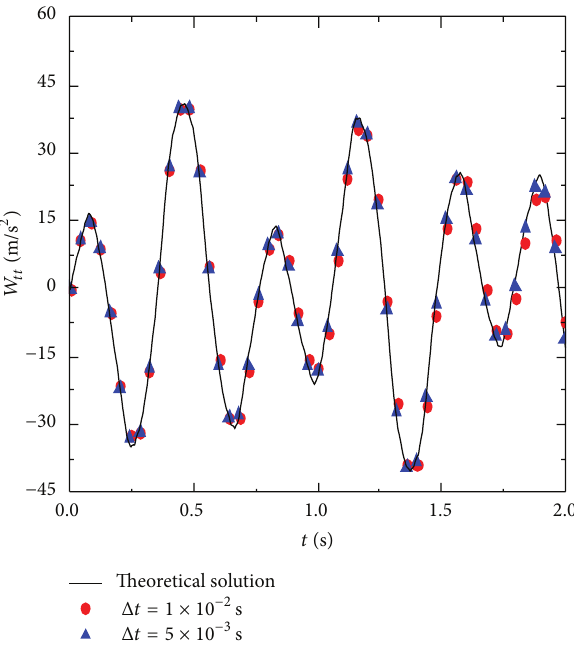
Figure 6: Numerical result of displacement 𝑊 with 5 × 5 manifold elements.